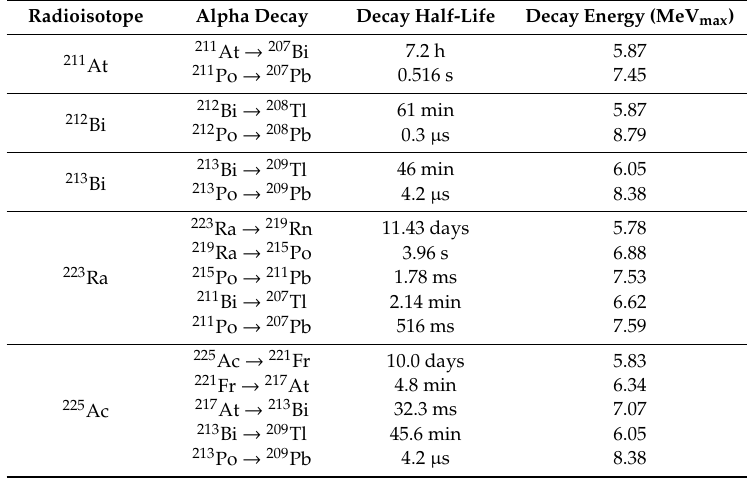
Table 4. Physical properties of α -emitters for biomedical